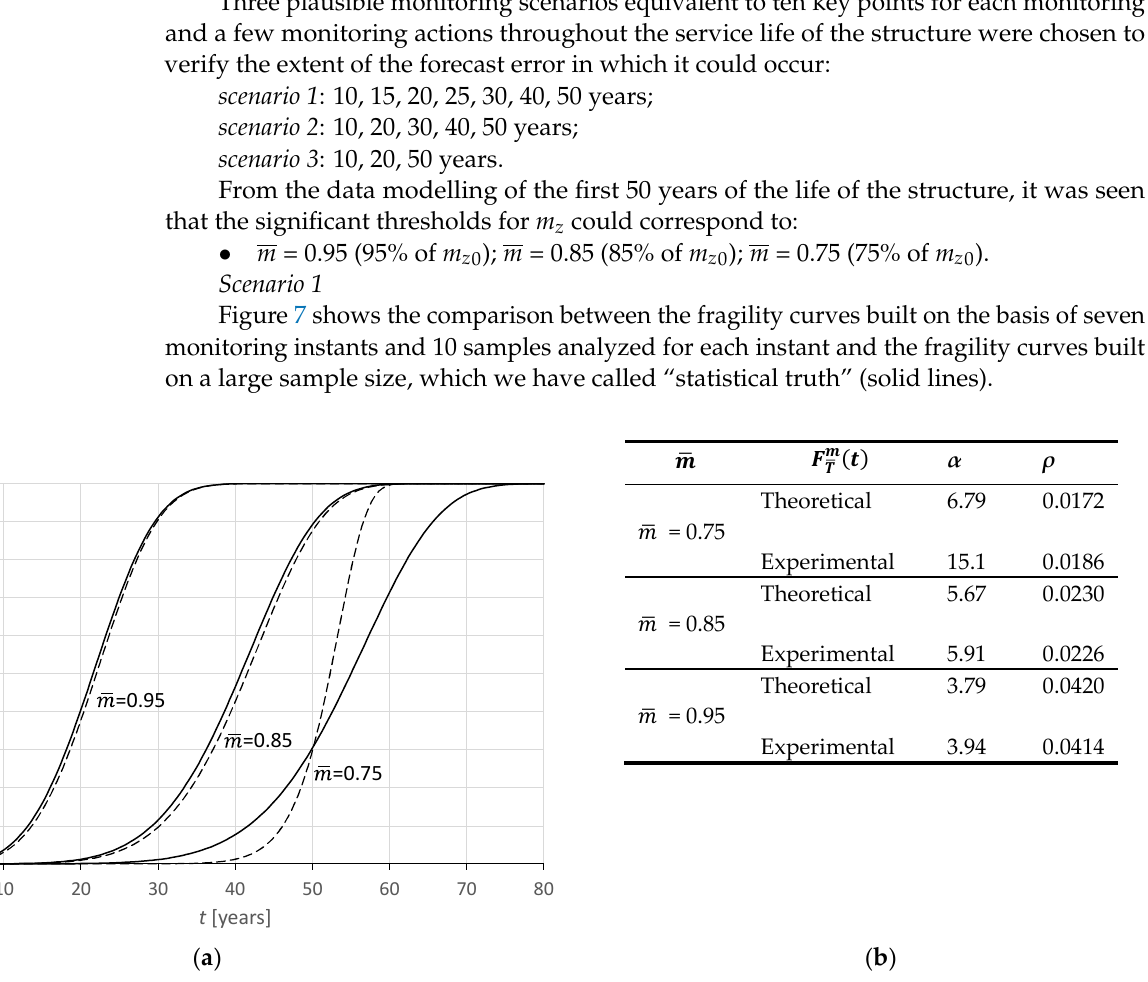
Figure 6. A c — scenario 2: ( a ) probability of exceedance for 3 of the most significant thresholds for the first 50 years of construction life; ( b ) experimental (symbols) and theoretical (lines) fragility curves relating to the probability of reaching each of the three residual ultimate bending moment levels considered.